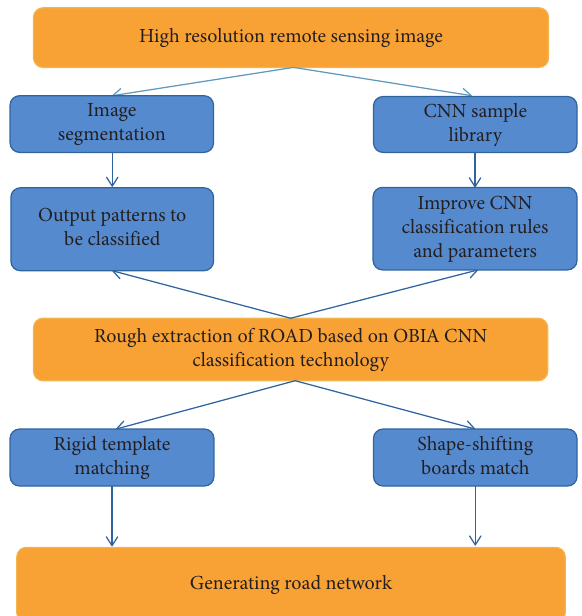
Figure 2: Flowchart of road extraction